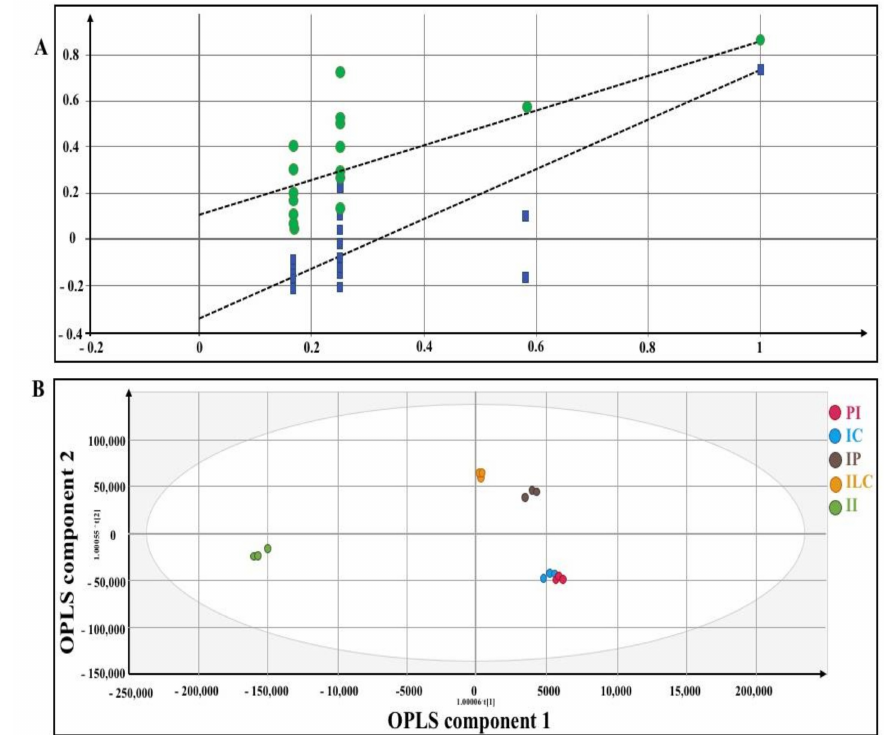
Figure 6. ( A ) Permutation results of partial least square-discriminant analysis (PLS-DA), ( B ) The OPLS score scatter plot of pure and adulterated H. itama honey using negative mode ionization in LC-MS analysis. PI = pure H. itama honey; IC = H. itama honey adulterated with cane sugar; IP = H. itama honey adulterated with palm sugar; ILC = H. itama honey adulterated with light corn syrup, and II = H. itama honey adulterated with inverted